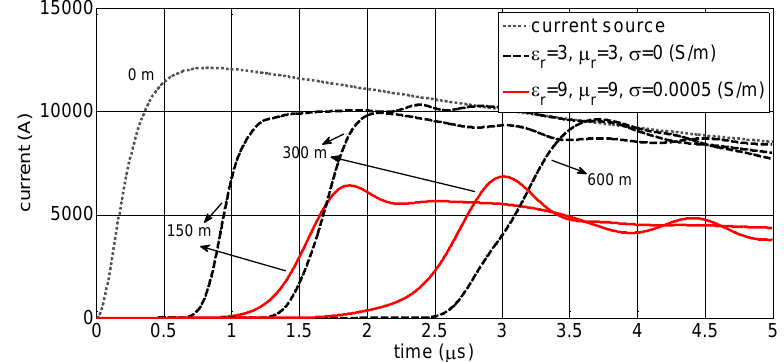
Figure 7. Current distribution along the lightning channel at different height calculated by CST-MWS for a 4 × 4 m 2 parallelepiped dielectric. Model B2 : Wire embedded in a fictitious dielectric and ferromagnetic coating.